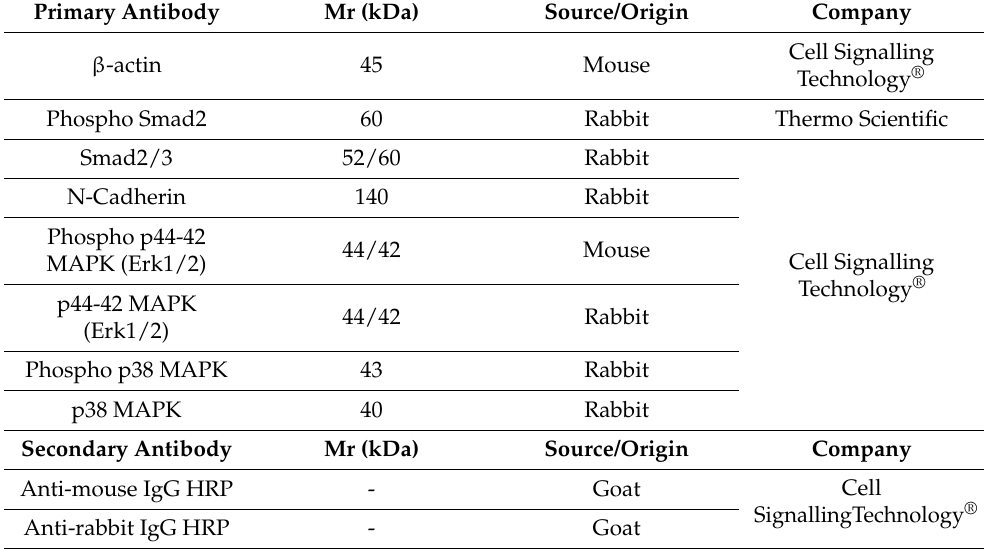
Table 4. Antibodies Used for